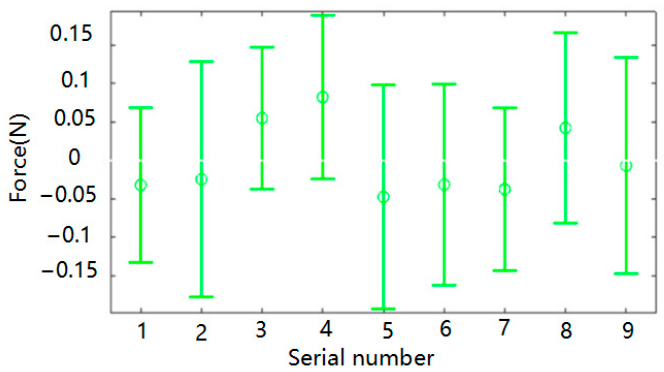
Figure 7. Residual